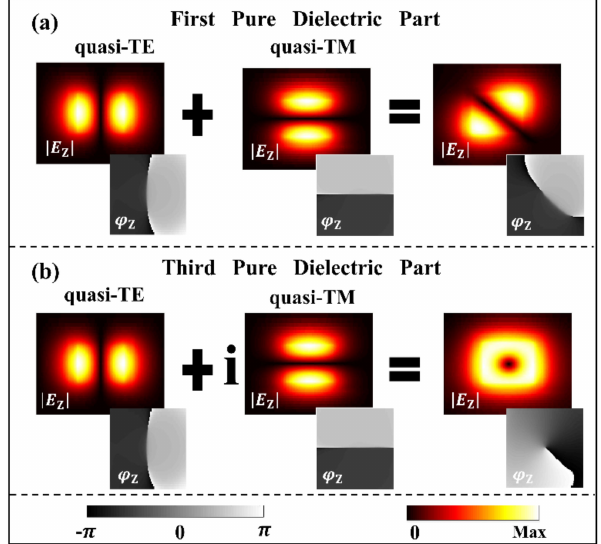
Figure 4. Longitudinal component of the electric fields ( | E Z | ) and phase distributions ( ϕ Z ) of the quasi-TE mode and the quasi-TM mode superimposed for the input linearly polarized beam with α = 45 ◦ transmitted in the first waveguide section ( a ) and for the generated output vertex beam in the third waveguide section when the Fermi level of the bottom graphene is set with E f = 0.9 eV and the Fermi level of the sidewall graphene is 0 eV ( b ),